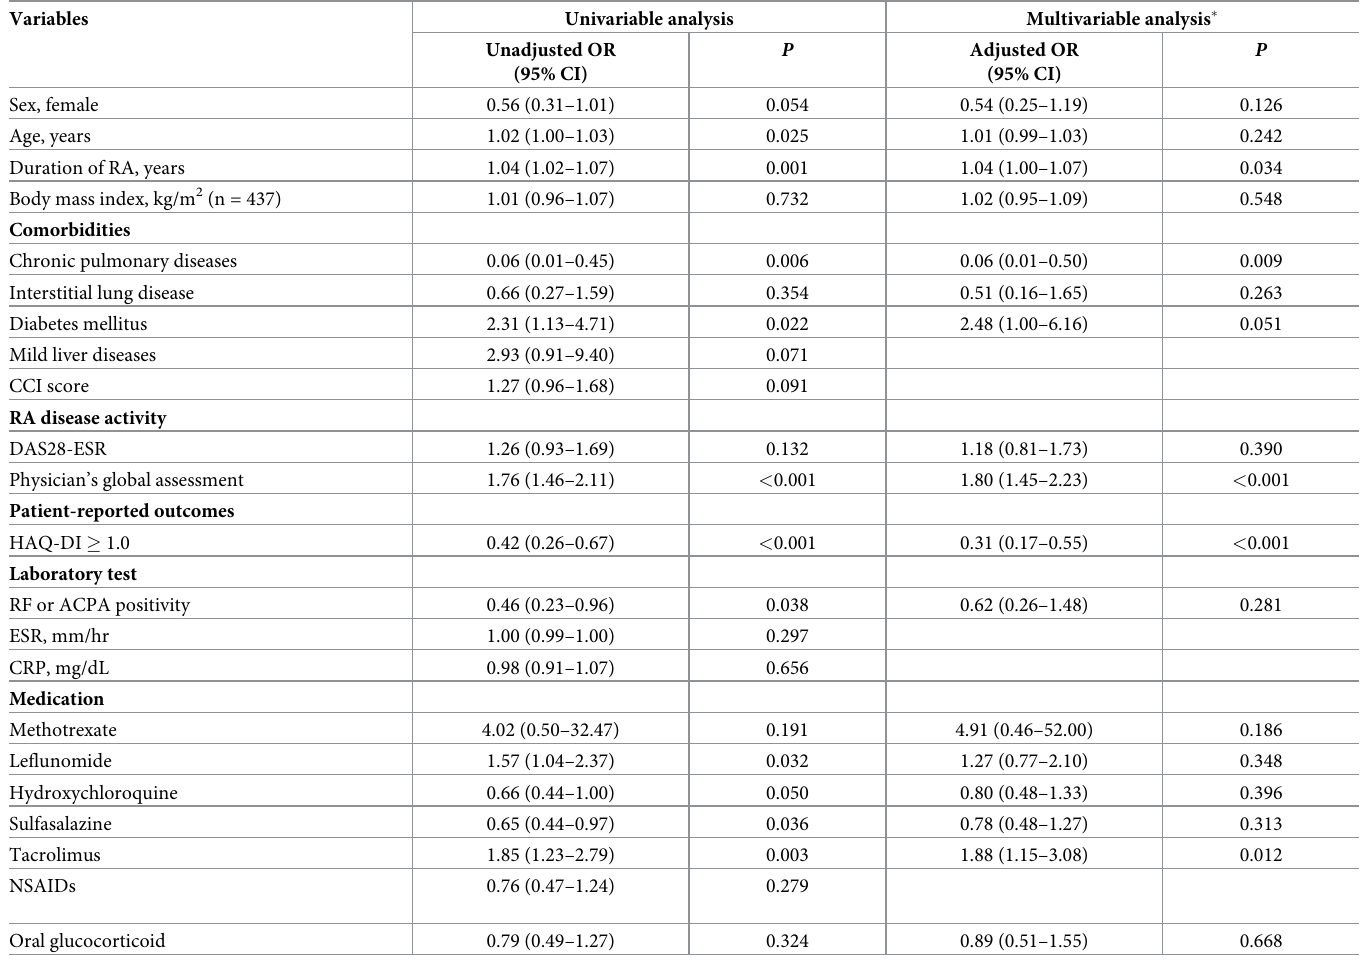
Table 2. Factors for starting JAKi compared with bDMARDs using binary logistic regression (n =